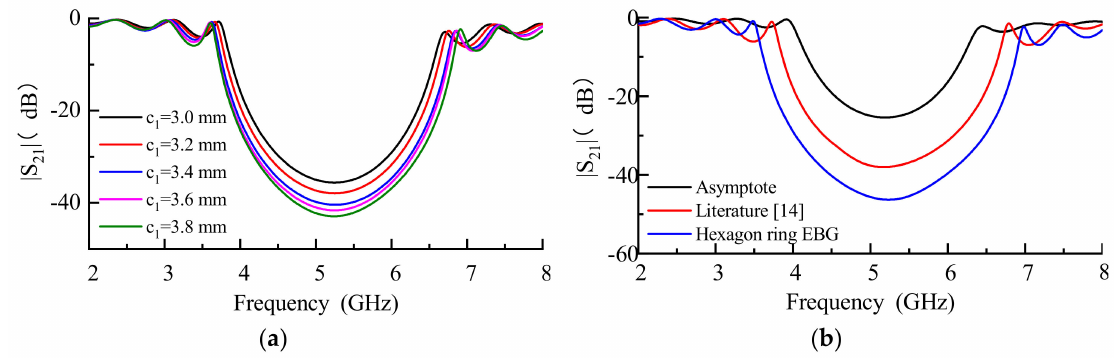
Figure 8. ( a ) Simulation with di ff erent c 1 using HFSS; ( b ) comparison of the filter in Reference [14] with the filter etched with a hexagon ring.